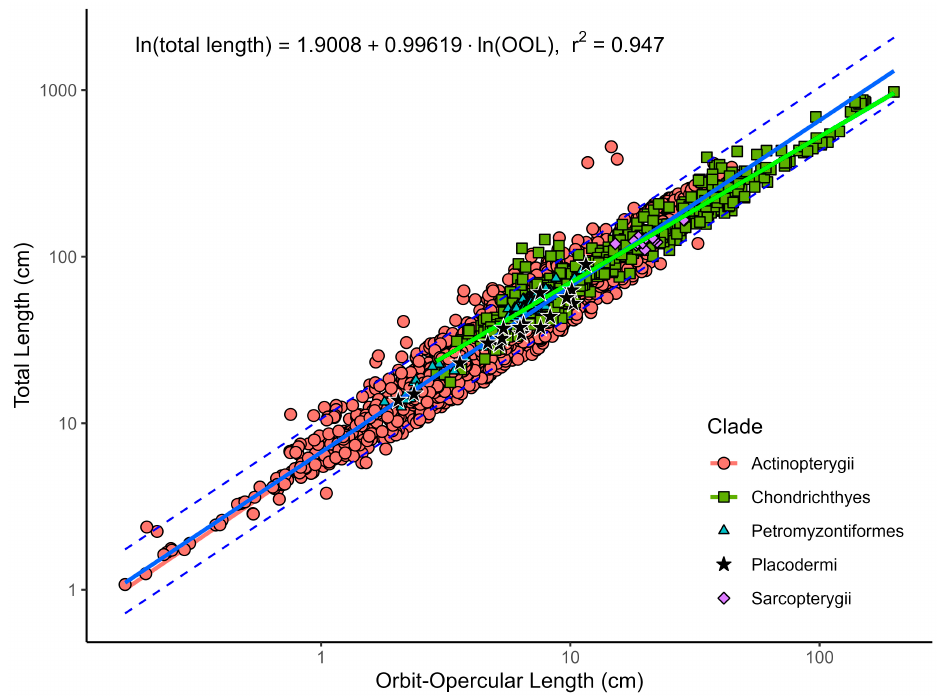
Figure 7. Plot of log 10 orbit-opercular length against log 10 total length in fishes. Solid and dashed blue lines represents best-fit regression line and 95% confidence intervals for all species,